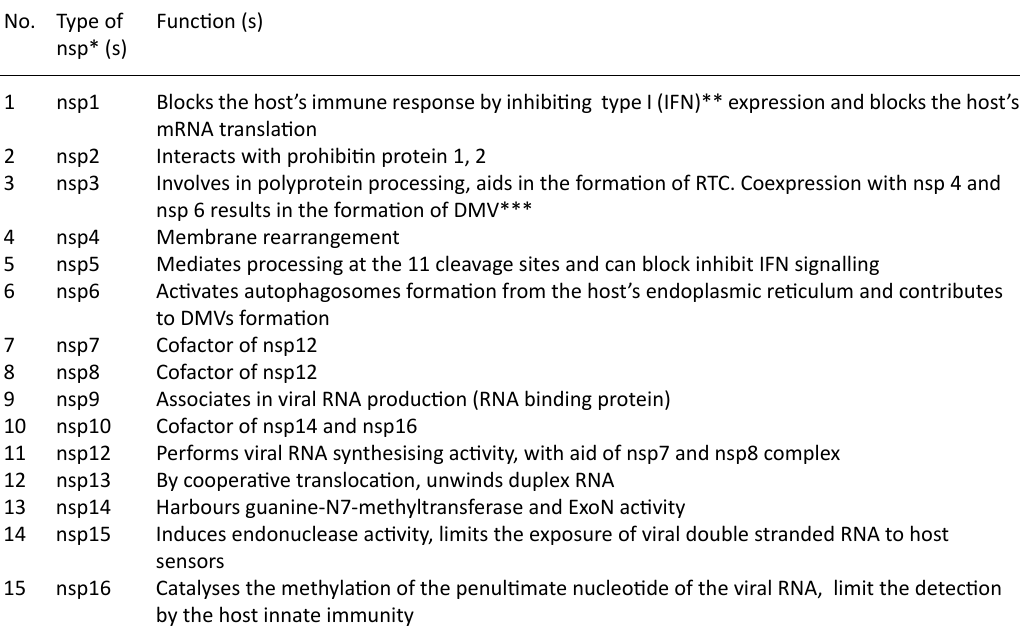
Table 1. The non-structural proteins of coronaviruses and its respective functions 52,43